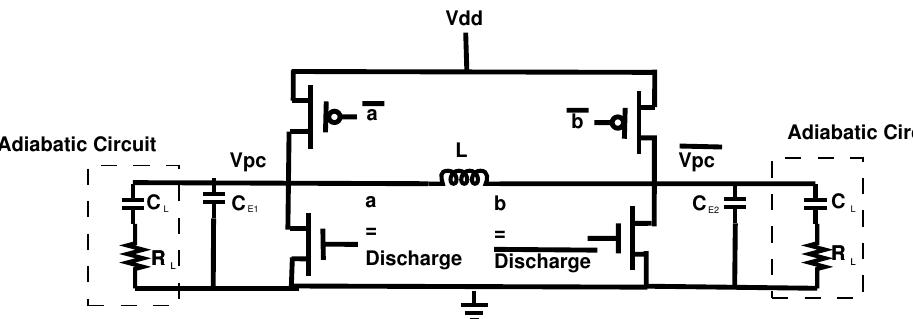
Figure 7. Structure of two-phase adiabatic clock generator [29].